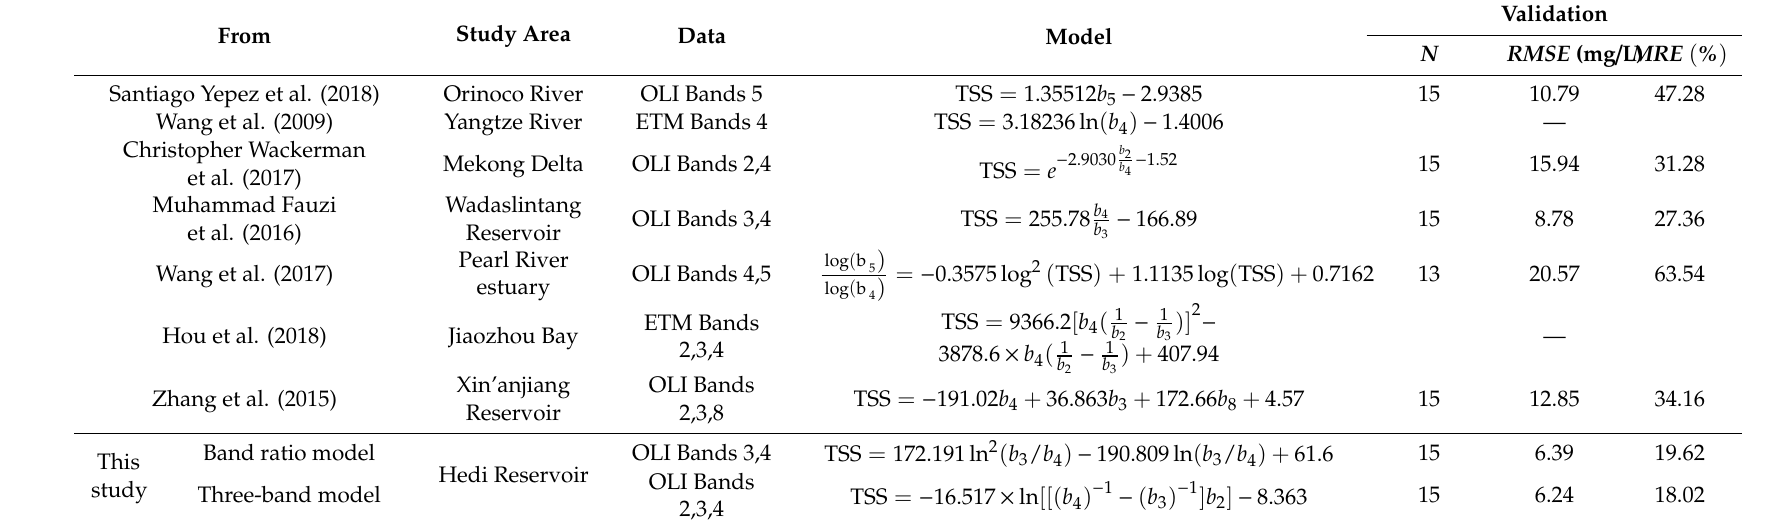
Table 4. Review of previous TSS retrieval models and the comparison of the validation accuracy of several TSS retrieval